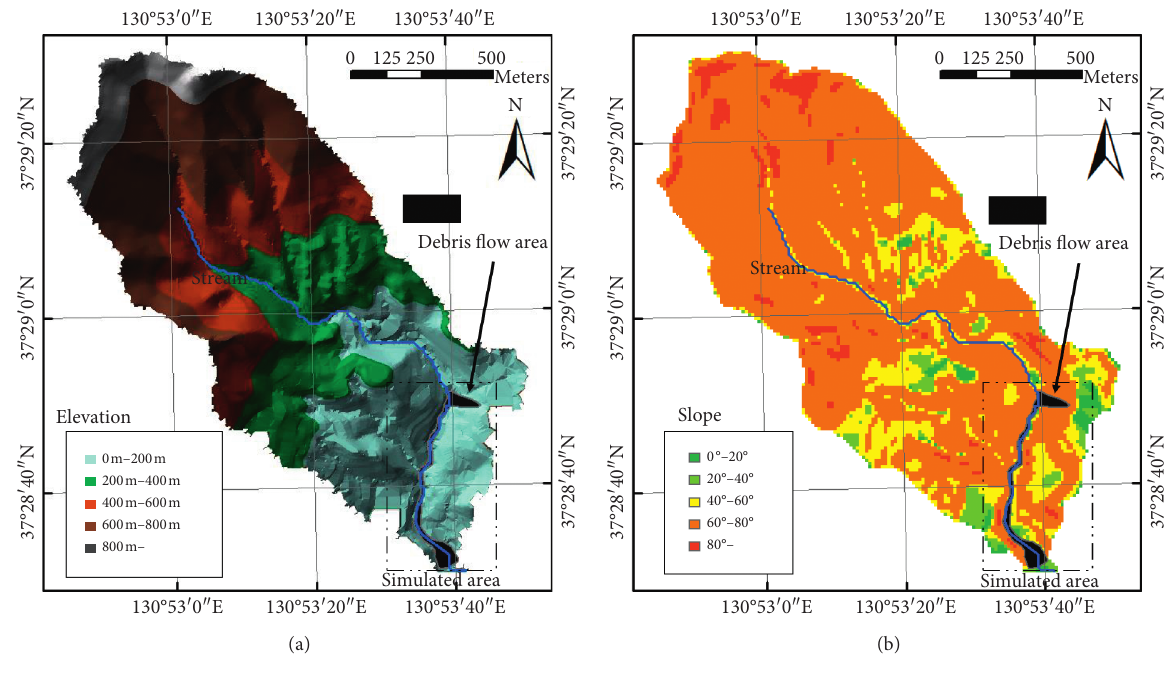
Figure 7: Spatial analysis for the study area’s basin. Table 3: Basin information of the study